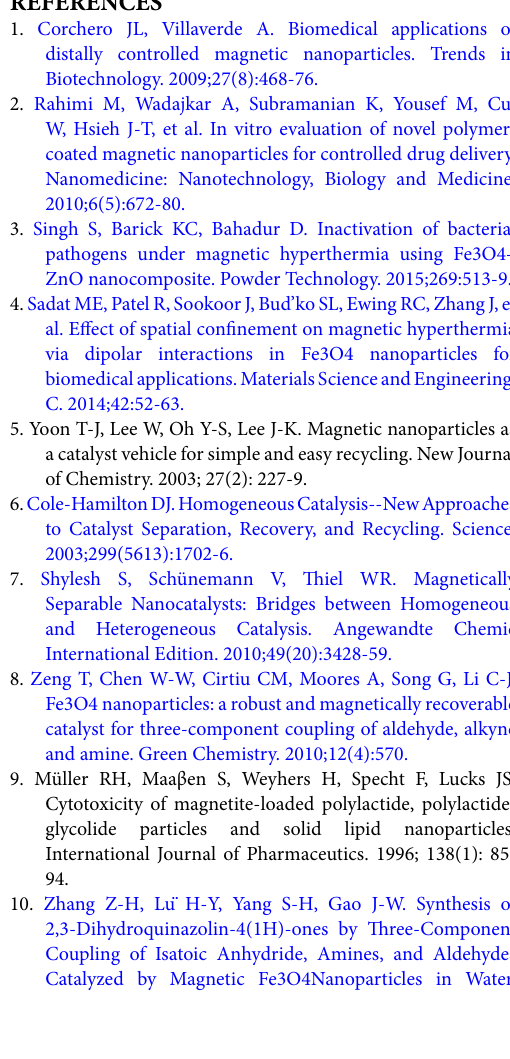
147 Nanochem Res 3(2): 142-148, Summer and Autumn 2018